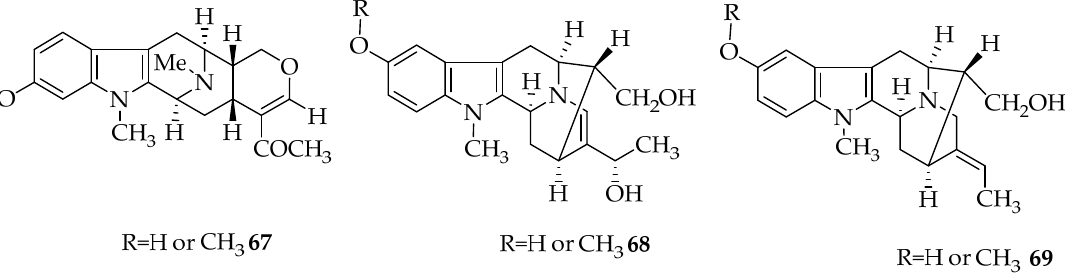
Figure 4. Putative biogenetic pathway to lumutinines A–D ( 16–19 ).